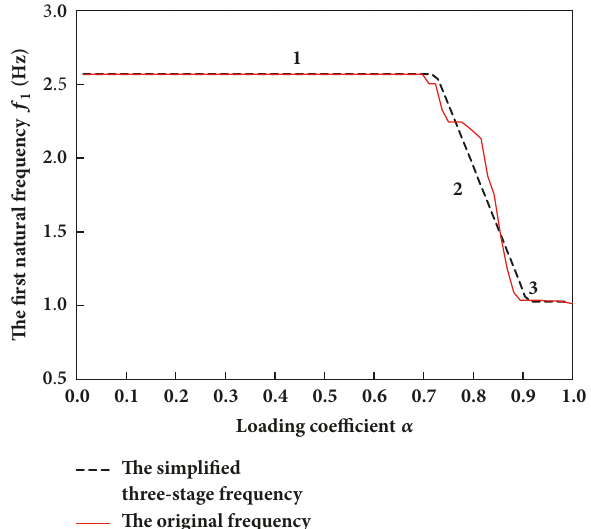
Figure 8: Comparison of the simplified three-stage frequency and original frequency of the three-storey eccentric frame